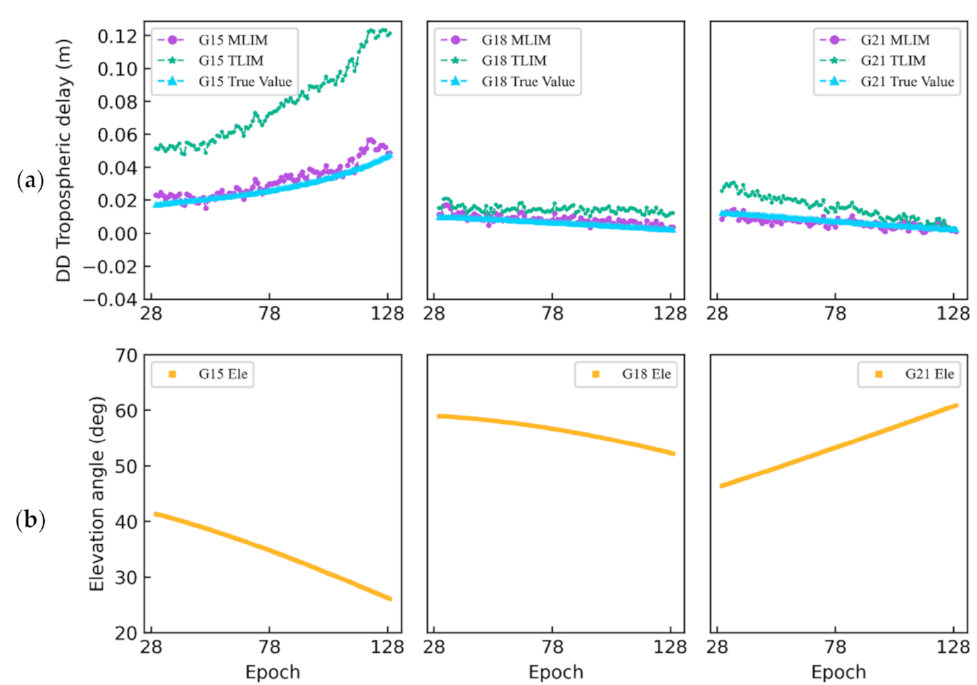
Figure 6. The DD tropospheric delay obtained by different methods ( a ) and elevation angles ( b ) for satellites G15, G18, and G21 at the rover station EWPP.